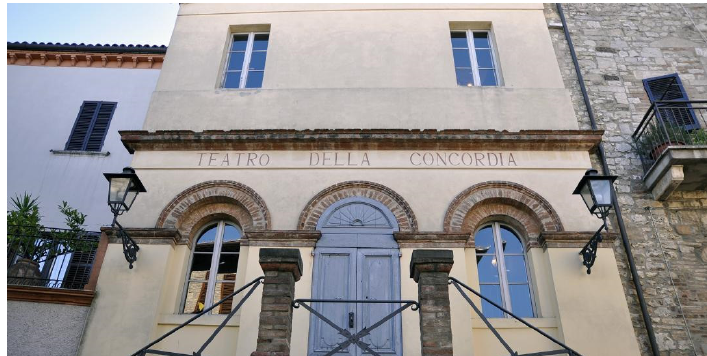
Figure 1. View of the Monte Castello di Vibio theatre [5].